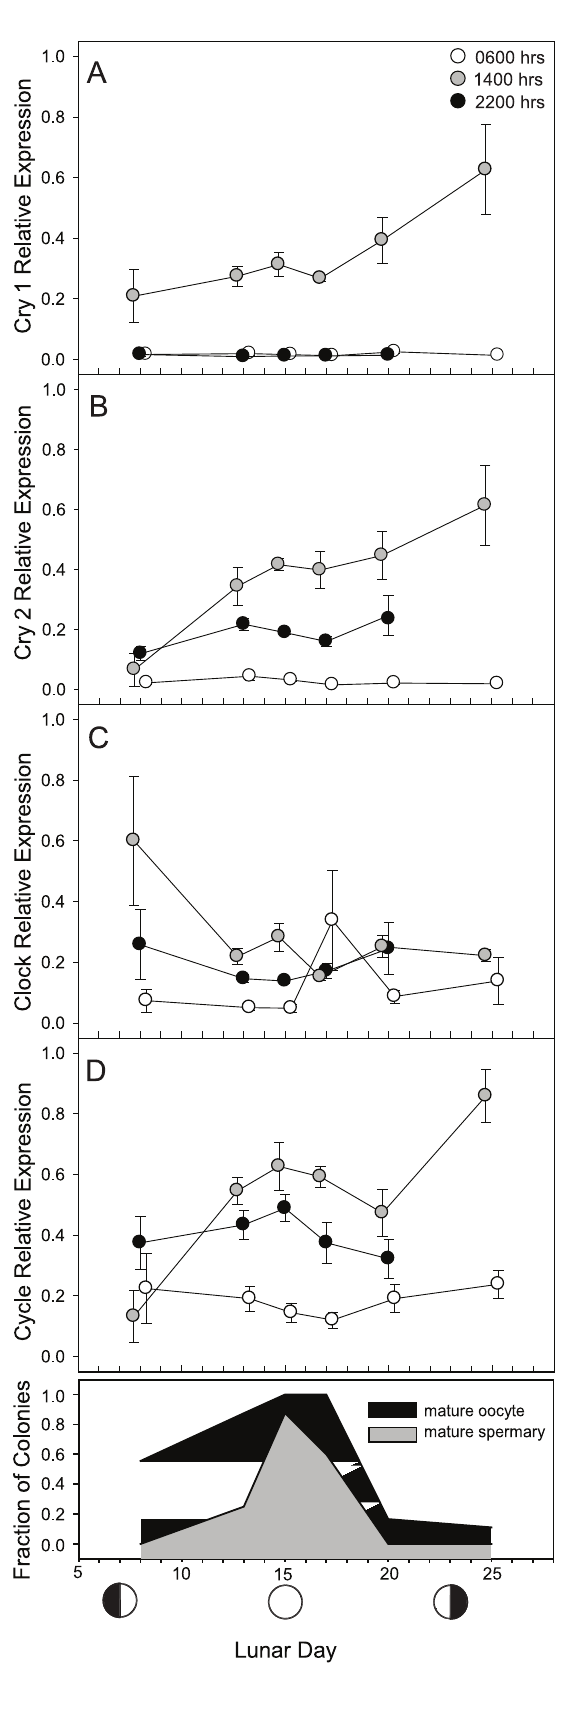
Figure 6. Relative expression of F.fragum clock genes over the lunar cycle. F. fragum samples were collected between July 7 and August 25, 2009 at 0600 h (white circles), 1400 h (gray circles) and 2200 h (black circles). Relative expression of cry1 (A), cry2 (B), clock (C), and cycle (D) normalized to total RNA and ef1 a expression (as described in the Materials and Methods) are shown as the mean 6 s. e. m. (n=4 to 5). The fractions of F. fragum colonies determined to contain mature oocytes (black) and spermaries (gray) are shown over the same time period (E). Two-way ANOVA indicates the following significant (p , 0.05) differences among times and days: cry1 expression at 1400 h was significantly elevated compared to expression at 0600 and 2200 hrs with no significant differences in expression among lunar days; cry2 expression at 1400 h was significantly elevated compared to expression at 0600 and 2200 h with expression on lunar days 20 and 25 significantly elevated compared to expression on day 8; clock expression at 1400 h and 2200 h was significantly elevated compared to expression at 0600 h with no significant differences in expression among lunar days; cycle expression at 1400 h was significantly elevated compared to expression at 0600 h and 2200 h, with expression on lunar day 25 significantly elevated compared to expression on lunar days 8, 17 and